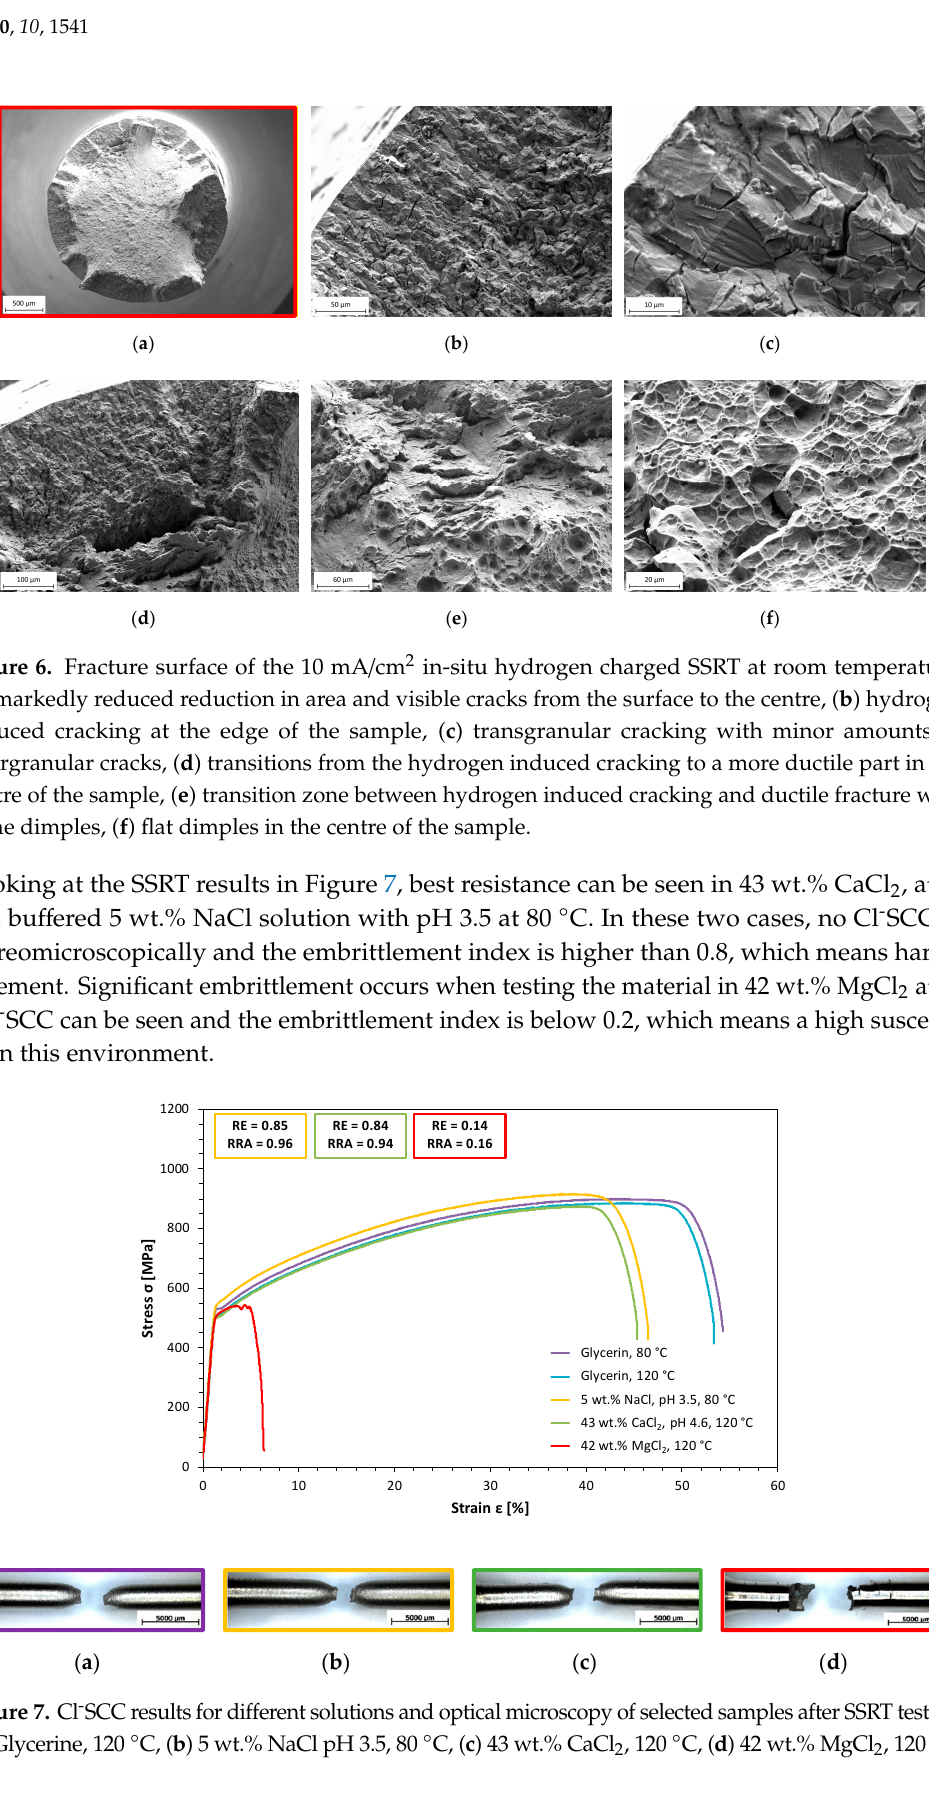
Figure 5. Fracture surface of the SSRT in air at room temperature without hydrogen charging: ( a ) ductile fracture appearance over the whole surface, ( b ) dimple structure at the edge of the sample, with clearly visible lines of deformation on the outer surface of the sample, ( c ) pure ductile structure in the center of the sample.